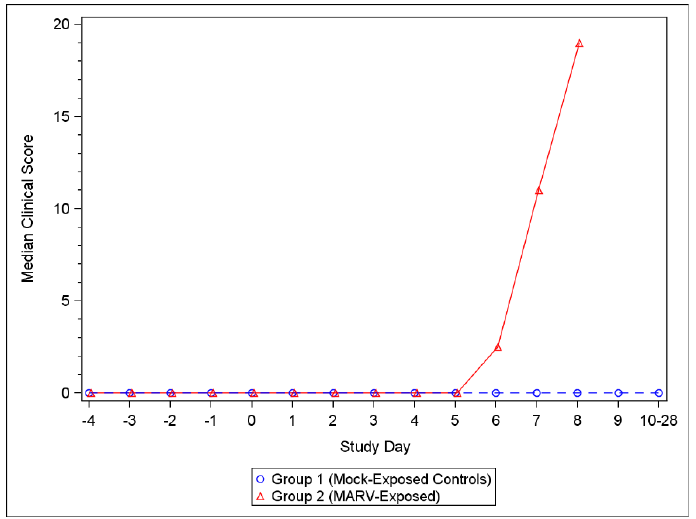
Figure 2. Median Clinical Scores for Mock-exposed and MARV-exposed animals. Following challenge, NHPs were scored for clinical presentation of disease at each observation. A score of 0–3 indicated that no intervention was needed; a score of ≥ 4 (or ≥ 3 in any single parameter) required additional monitoring; a score of ≥ 10 required euthanasia. See Table S1 for the scoring criteria, and Tables S4 and S5 for individual clinical scores.